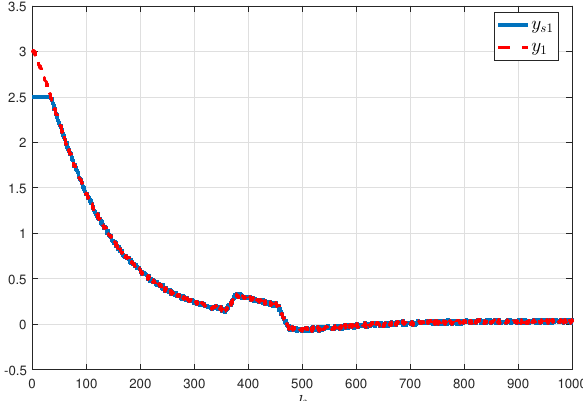
Figure 9. Actual and ideal measurements of y .